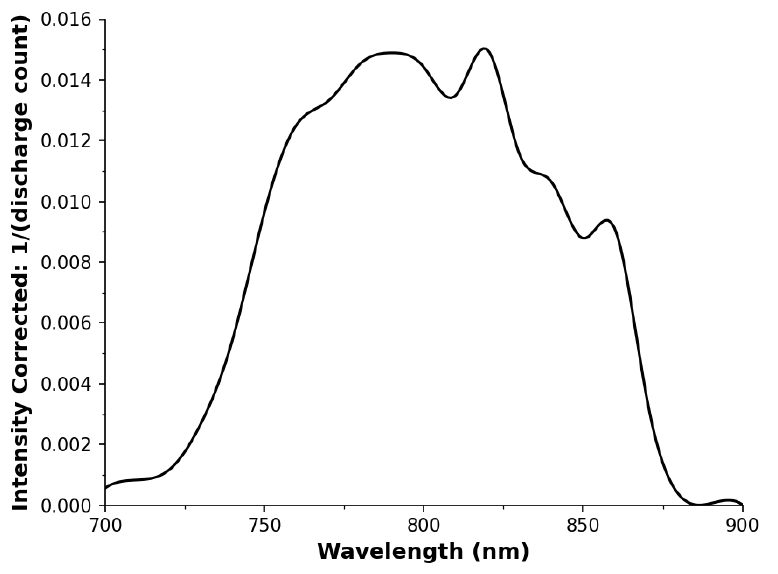
Figure A4. Corrected